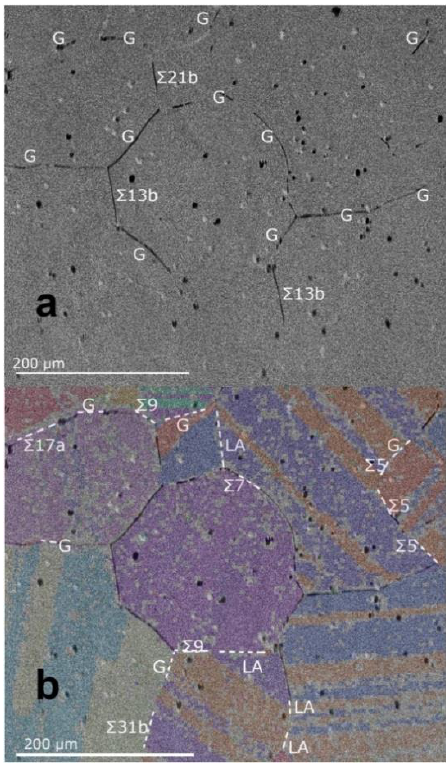
Figure 23. ( a ) Indexing of corroded grain boundaries based on orientational image mappings (OIM) established by electron backscatter diffraction (EBSD). ( b ) Indexing of uncorroded grain boundaries based on OIM (overlaid). “G” indicates general grain boundary geometry with no lattice site coincidence, “LA” indicates low angle [287]. Reprinted with permission from John Wiley & Sons, Inc.